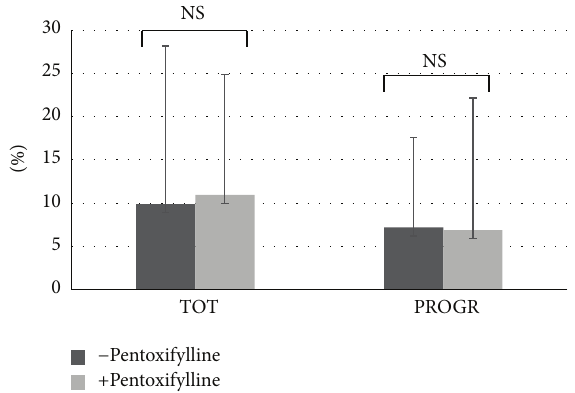
Figure 4: Sperm motility after treatment with pentoxifylline. Values are shown as mean ± SD. Statistical difference between pre- and post-pentoxifylline not significant